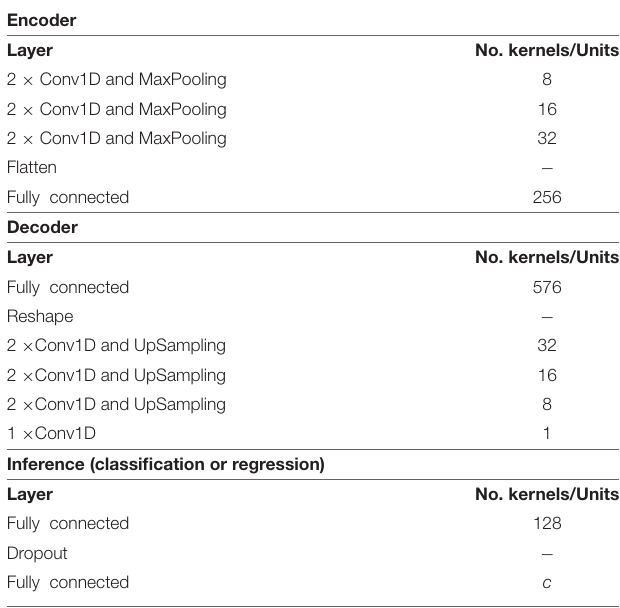
TABLE 1 | DDCAE architecture: the MaxPooling and UpSampling operations are performed with an identical pooling size set to 2 and a stride set to